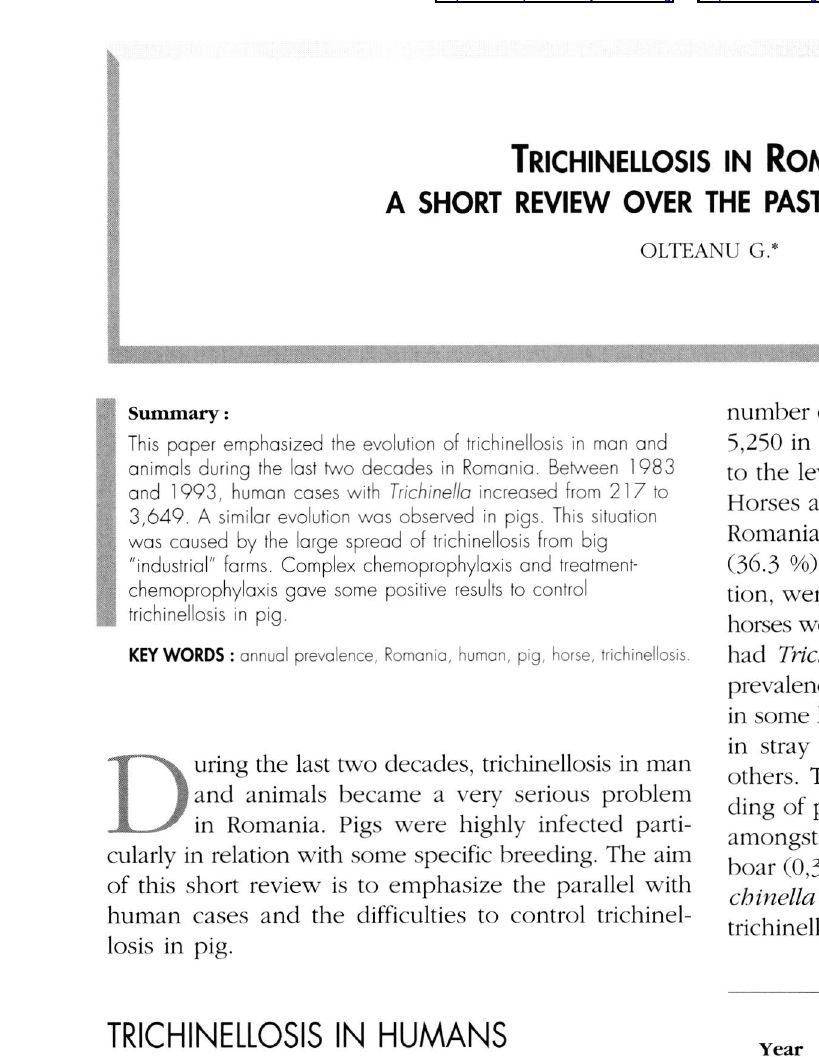
Table I. - Evolution of trichinellosis in human and pig during the last 10 years in